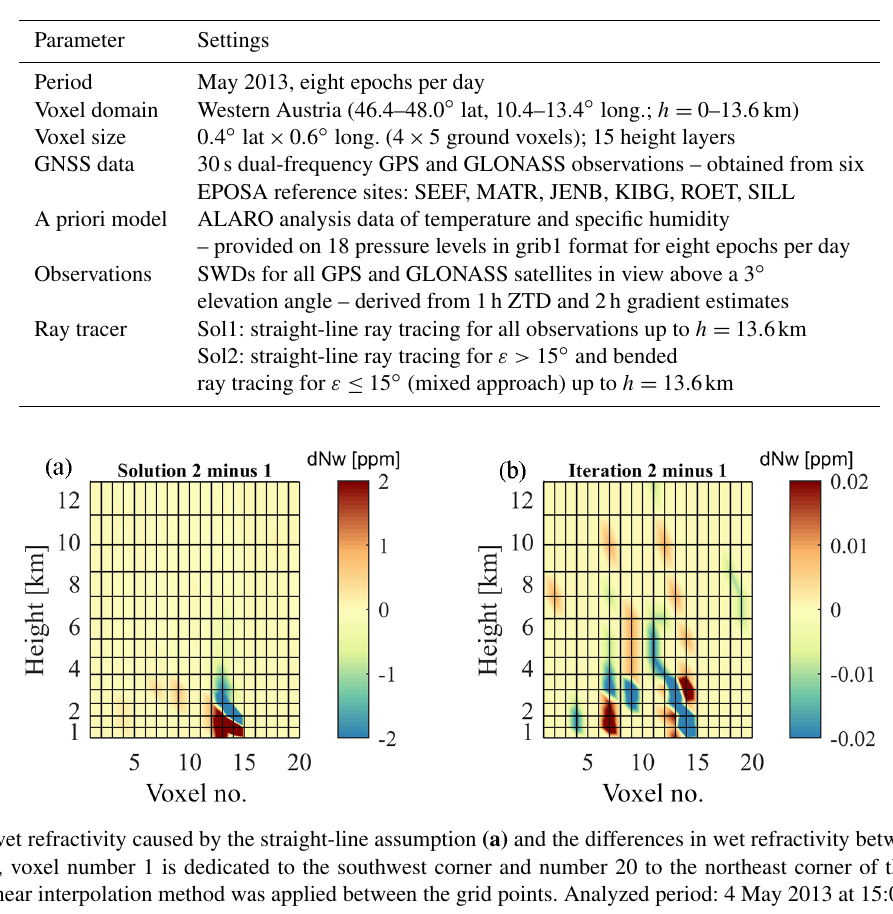
Table 1. Summary of GNSS tomography test case settings.